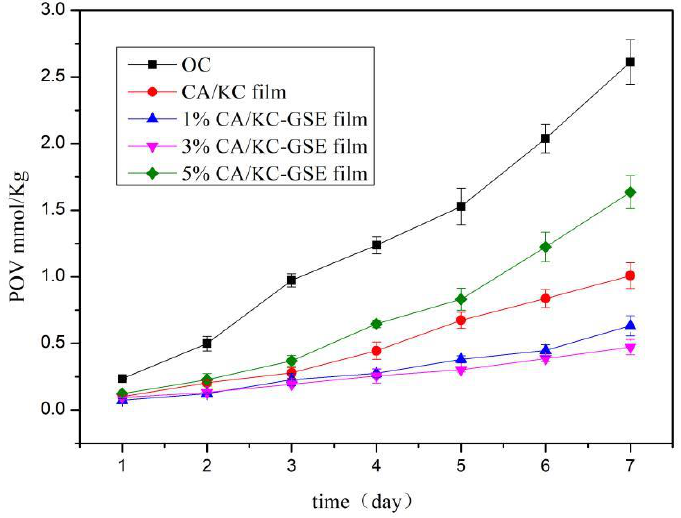
Figure 7. POV of lard packed by CS/ κ C-based films with a different concentration of GSE.